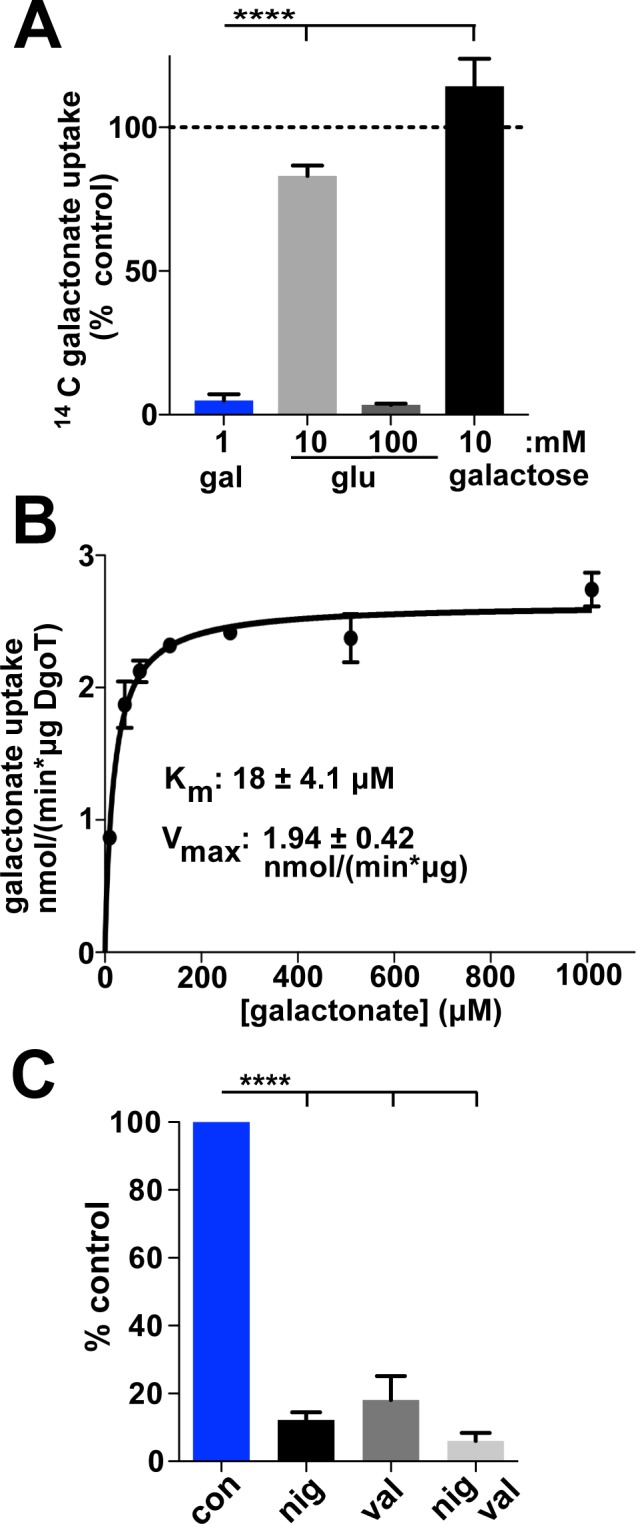
Properties of gal transport by DgoT.(A) Uptake of 14C-gal by E. coli expressing DgoT shows inhibition by 1 mM gal but not by 10 mM glu or galac (n = 3). (B) Representative concentration dependence of 14C-gal uptake by cells expressing WT DgoT. The data from multiple experiments were each fit to the Michaelis-Menten equation and used to calculate the mean Km = 18 ± 4.1 μM and Vmax = 1.94 ± 0.42 nmol/(min × μg) (n = 3). (C) E. coli spheroplasts expressing WT DgoT show inhibition of gal uptake by the H+ ionophore nig (dissipating ΔpH) and val (dissipating Δψ), demonstrating electrogenic cotransport of H+ and gal. The numerical data underlying this figure are included in S1 Data. ****p < 0.0001; con, control; DgoT, D-galactonate transporter; gal, galactonate; galac, galactose; glu, gluconate; Km, Michaelis-Menten constant; nig, nigericin; val, valinomycin; Vmax, maximal rate; WT, wild type.